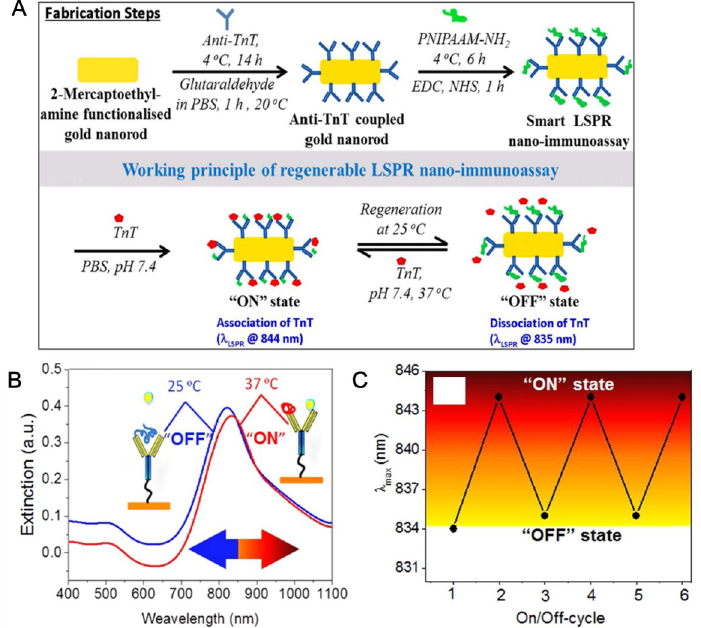
Figure 3. ( A ) Schematic presentation of fabrication steps involved with regenerable